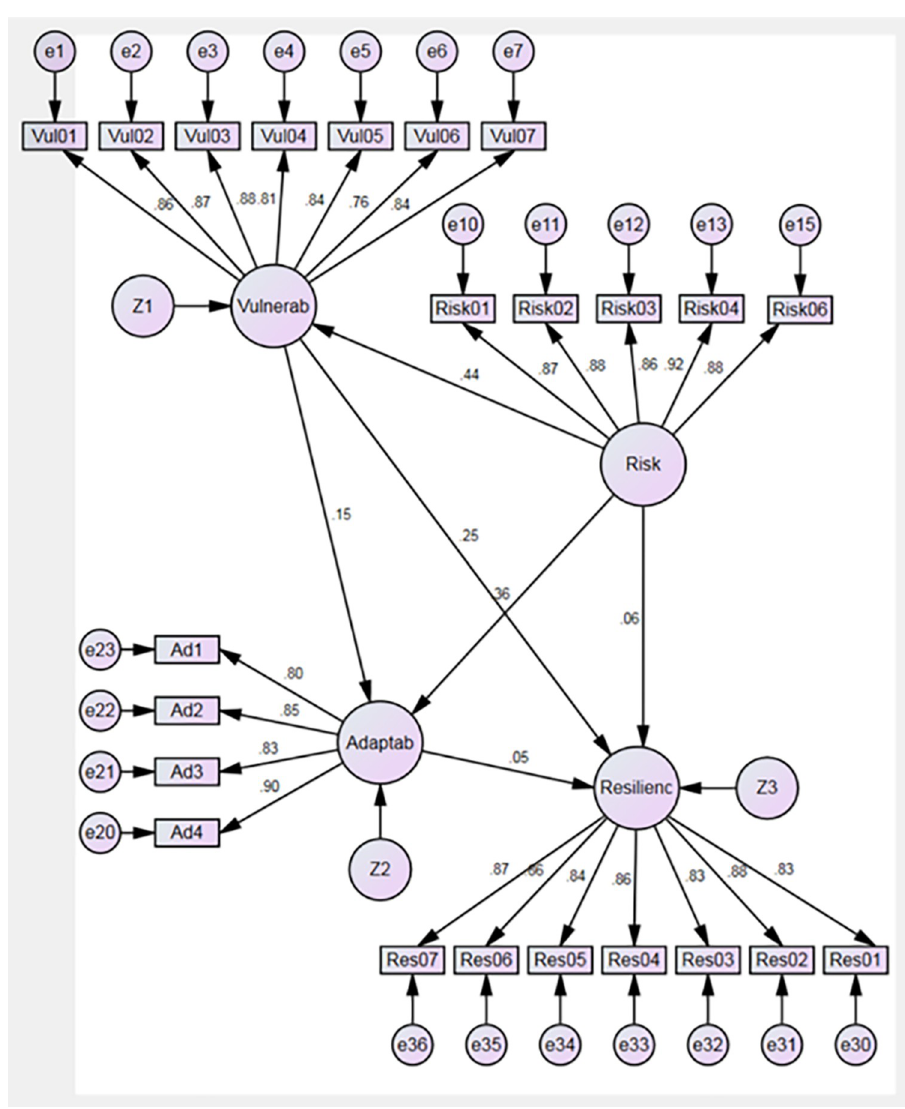
Fig 6. Result prior to pandemic. Source: By the authors